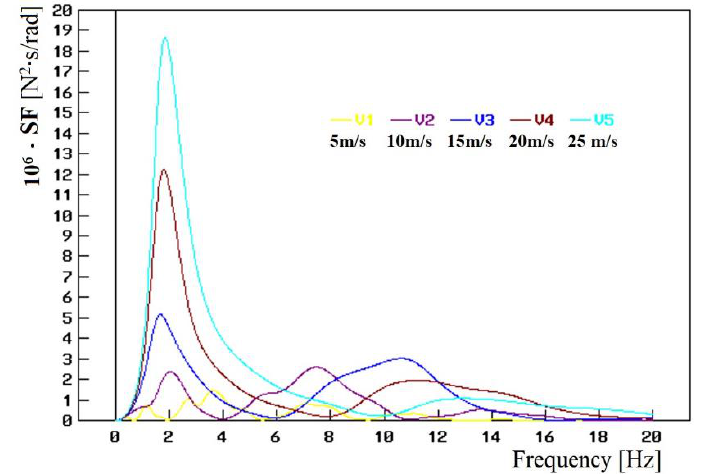
Figure 11. Power spectral density S F (ω) of the force F on the connection between the tractor ’ s fifth wheel and the semitrailer’s kingpin for road C (average) and five vehicle speeds v: 5 m/s, 10 m/s, 15 m/s, 20 m/s, and 25 m/s.